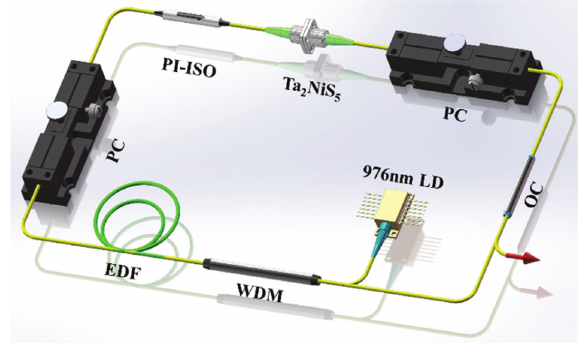
Figure 6: Diagram of the Erbium-doped fiber laser